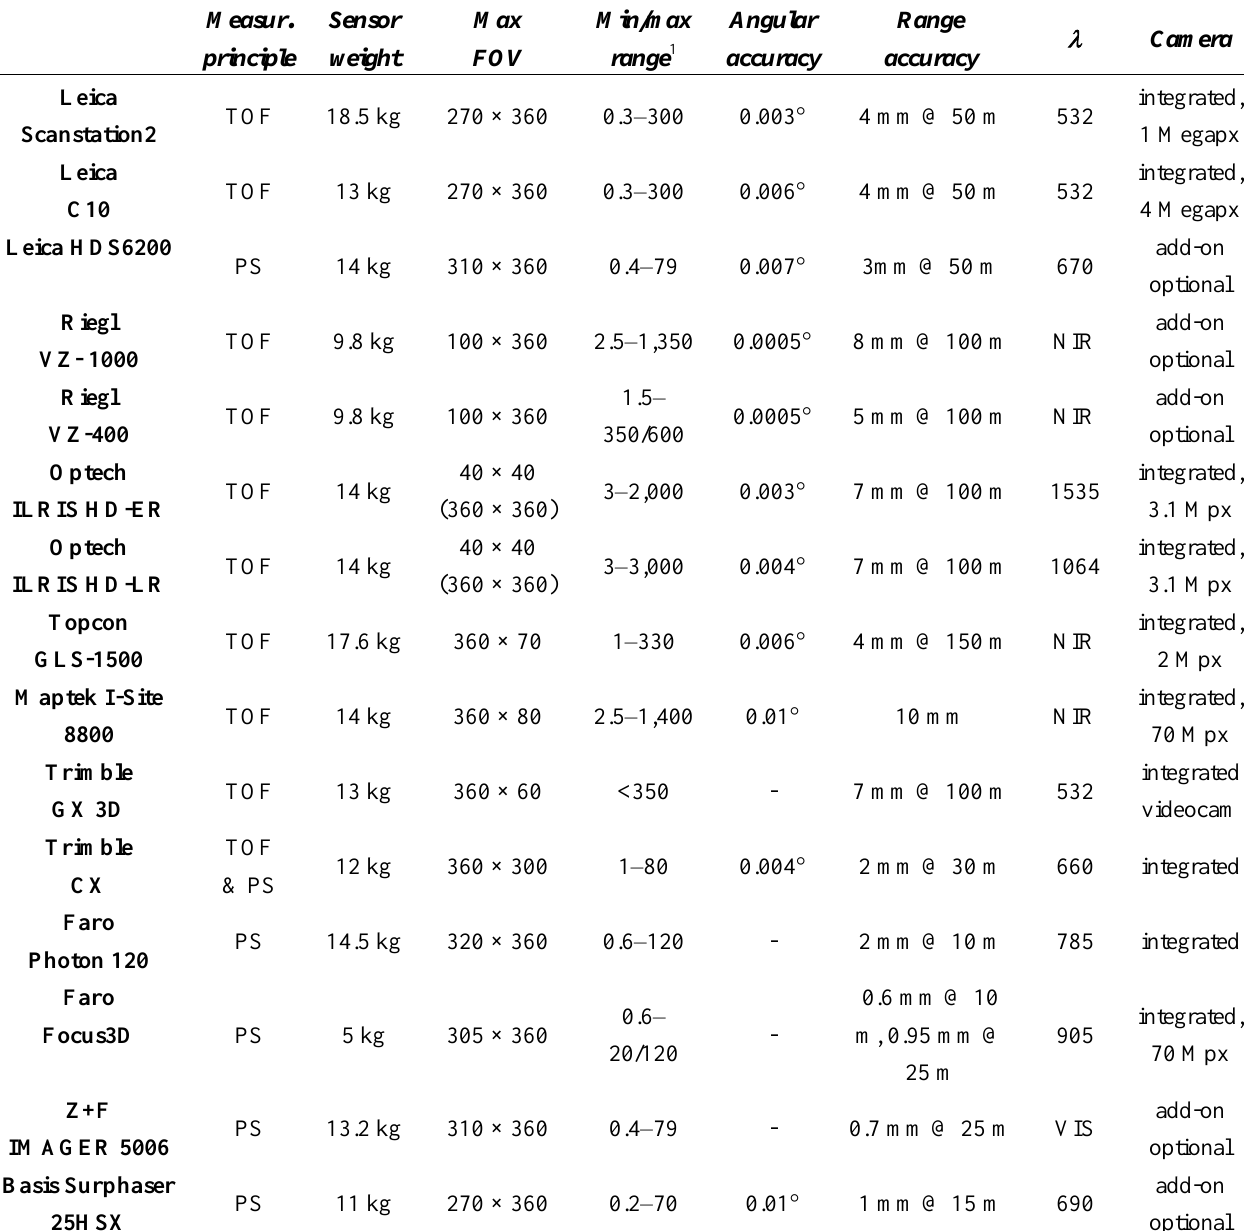
Table 3. Most common long-range terrestrial laser scanners (TOF = Time-of-Flight; PS = Phase Shift;  = wavelength in nm; 1 80%